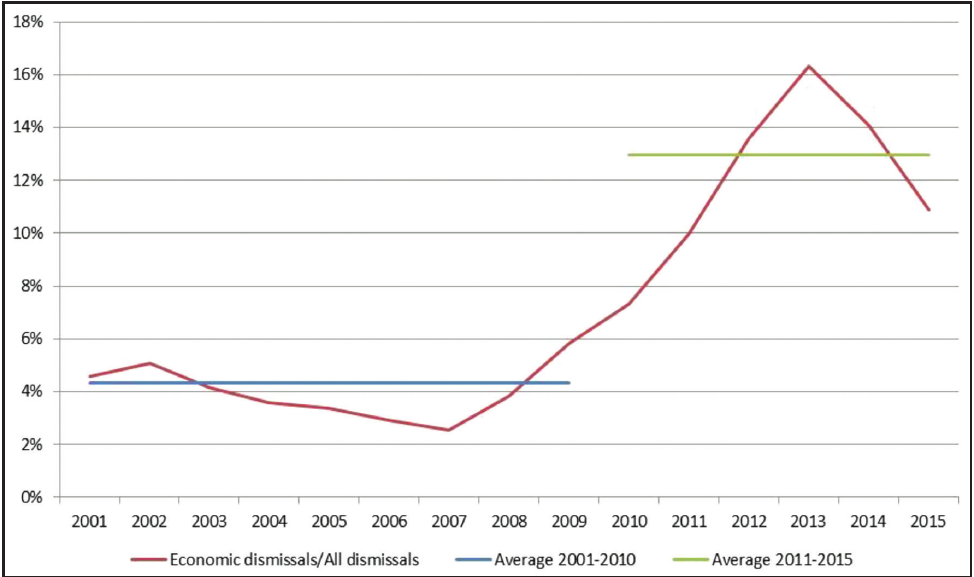
Proportion of economic dismissals over all dismissals.